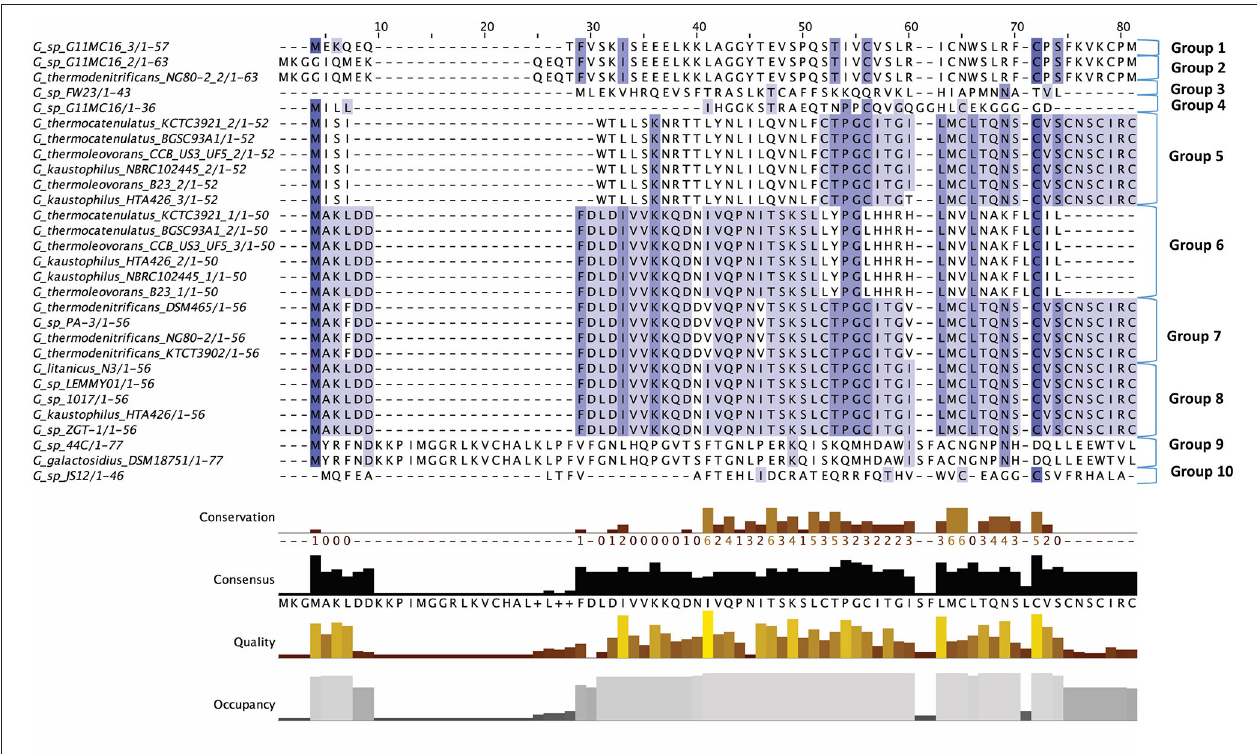
FIGURE 2 | Multiple Sequence Alignment (MSA) of those lantibiotic peptides predicted. In some genomes multiple peptides were predicted within a single bacteriocin cluster and were therefore included as part of this alignment.